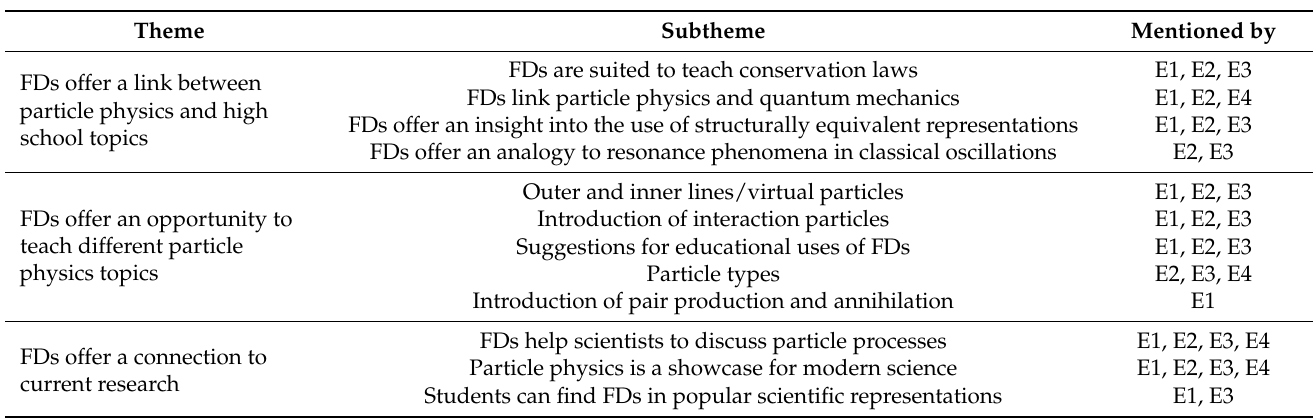
Table 2. Themes and subthemes for the dimension opportunities. The order of the subthemes within a theme is according to the frequency of overall